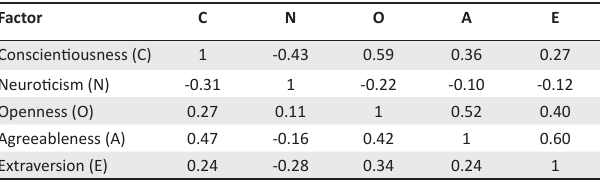
TABLE 3: Basic Traits Inventory factor correlations for the pooled adolescent group and normative working adult